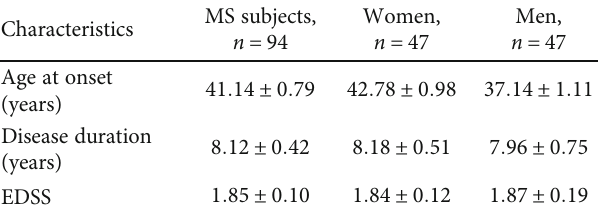
Table 1: The clinical characteristic of MS subject group.